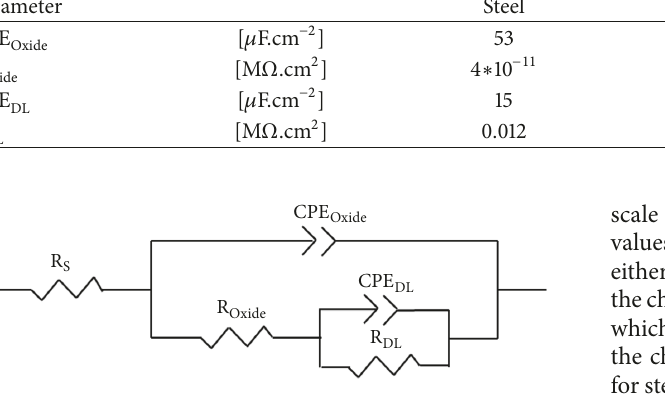
Figure 5: Proposed equivalent electrical circuit for fitting EIS